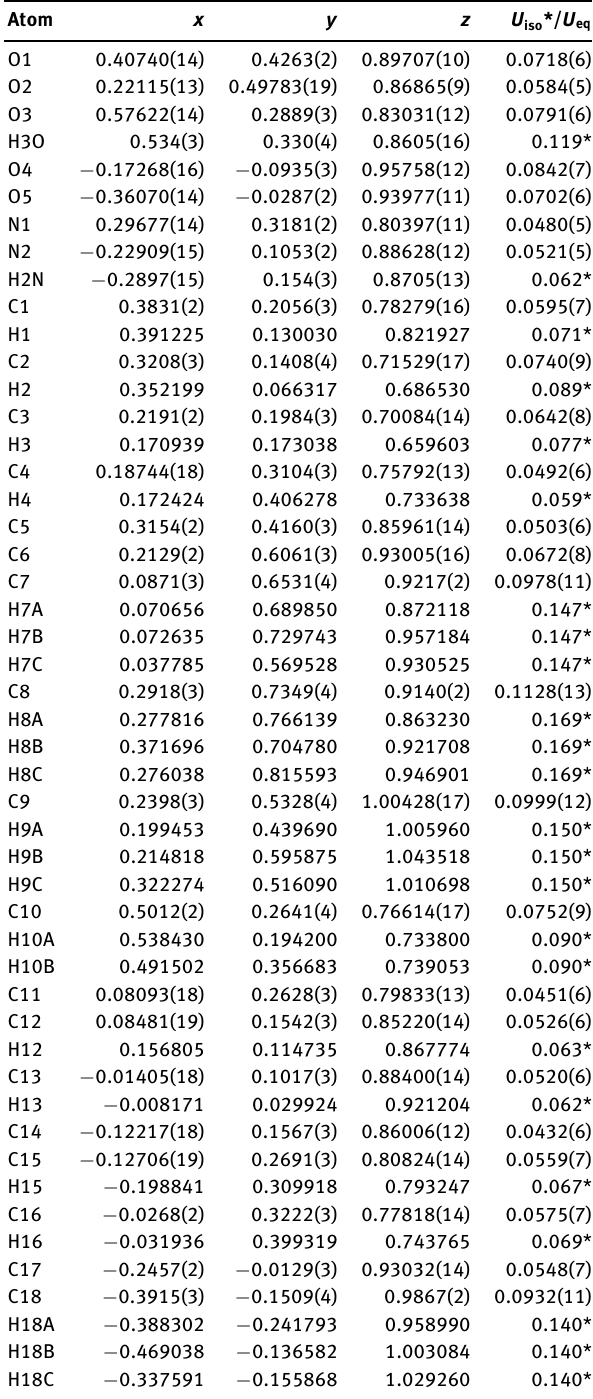
Table 2: Fractional atomic coordinates and isotropic or equivalent isotropic displacement parameters (Å 2